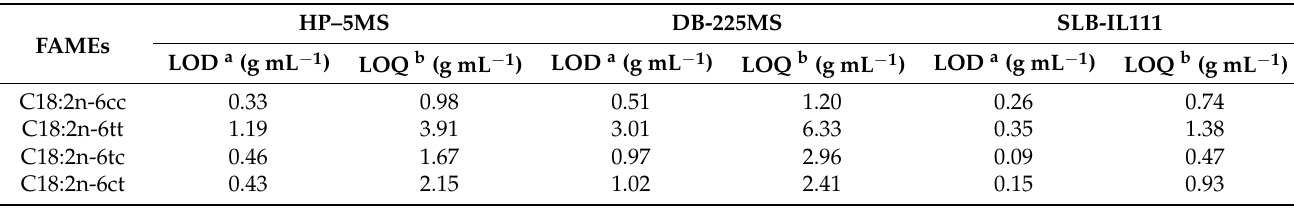
Table 3. Limit of detection (LOD) and limit of quantification (LOQ) values for components in the CRM47791 mixture determined by GC–MS using the optimized methods for the three GC columns. The optimized experimental conditions are detailed in Materials and